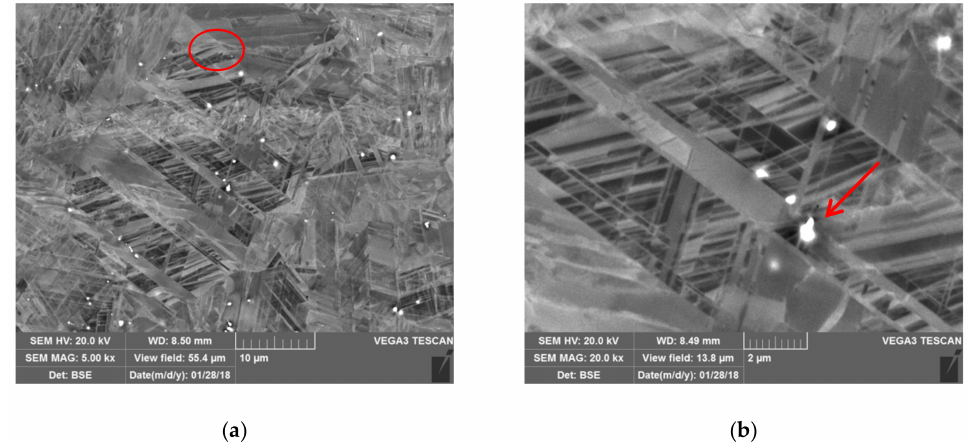
Figure 4. The backscattered electron image of Fe22Mn12Cr4Co0.2Nb0.02C annealing at 1100 ◦ C. ( a ) Backscattered electron image after annealing. ( b ) Enlarged image inside the